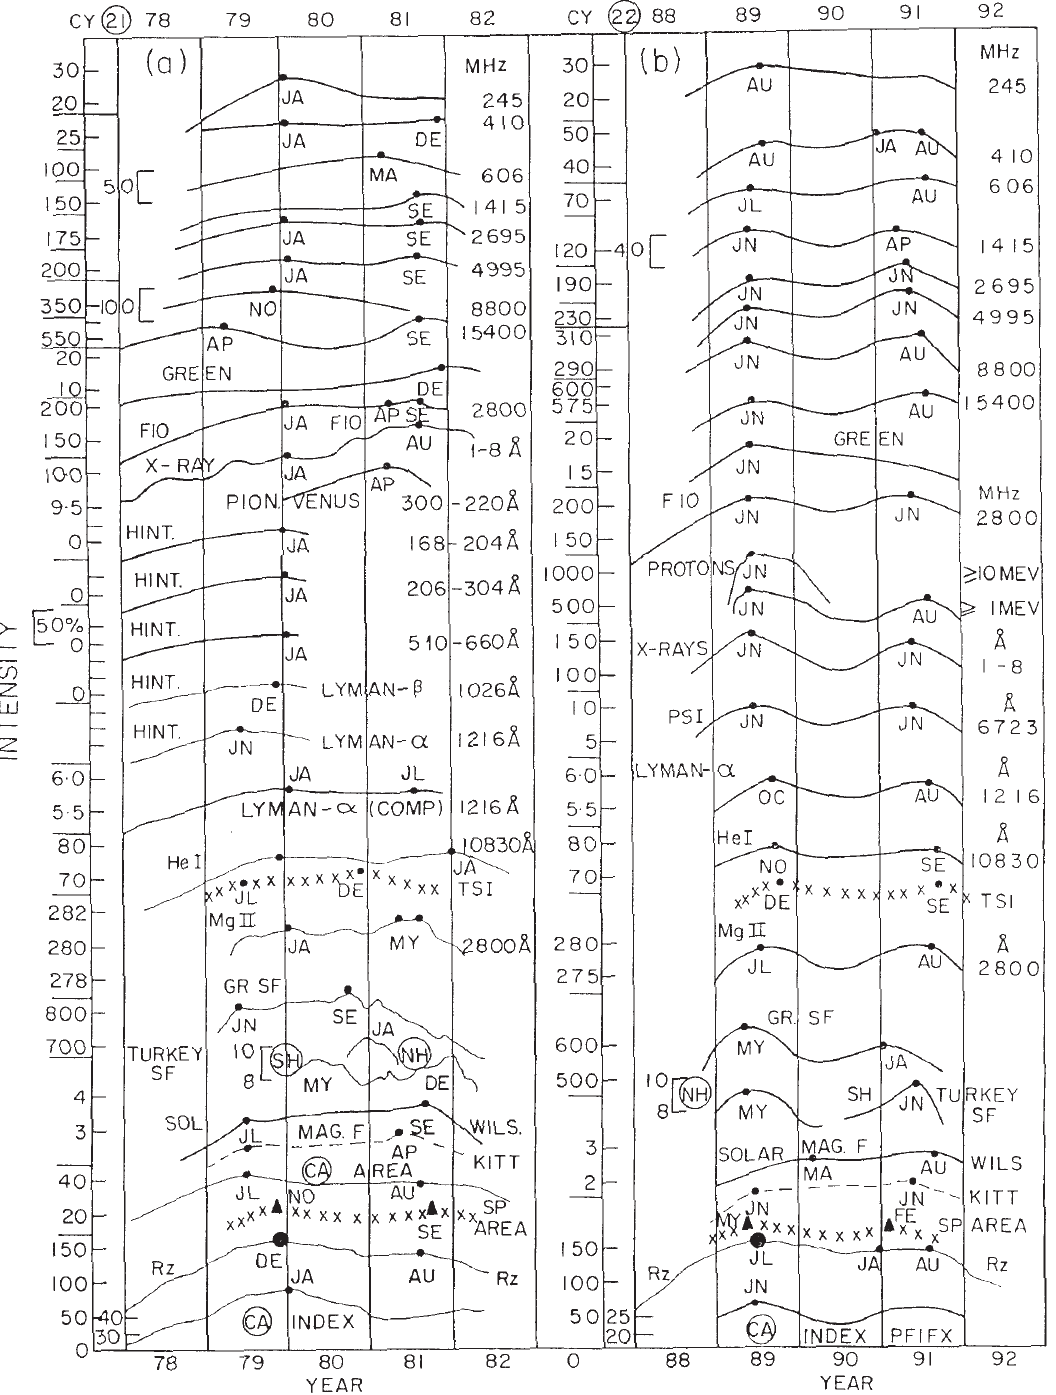
Fig. 5. Plots of smoothed values of the various solar indices in years near sunspot maxima of (a) cycle 21, 1978–1982, and (b) cycle 22, 1988–1992. The full dots indicate